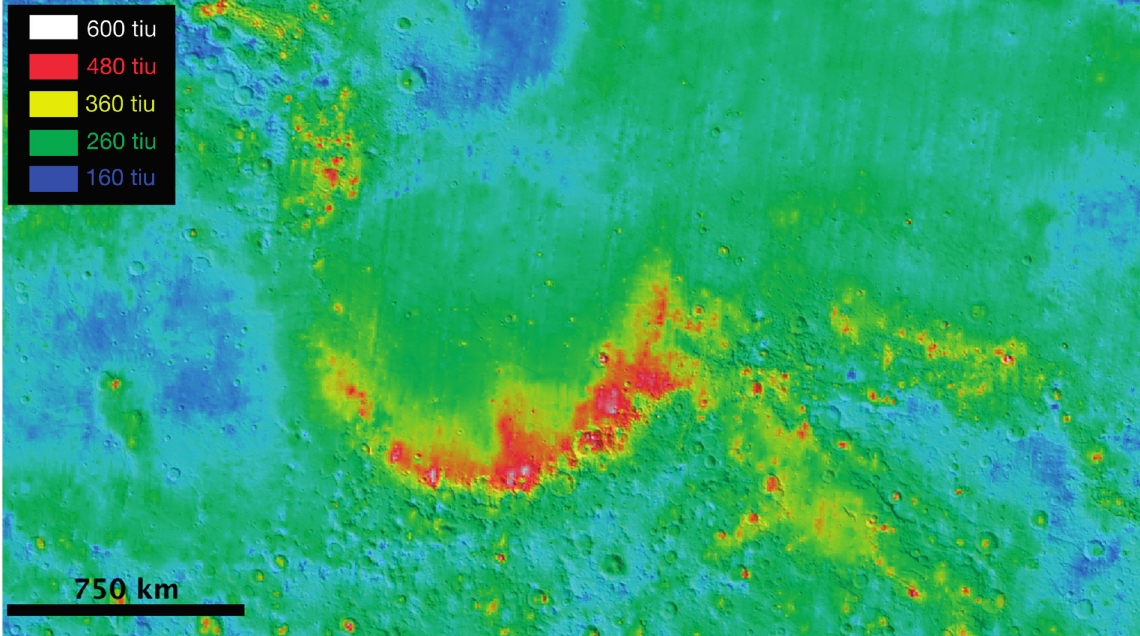
Figure 3. Variation of thermal inertia values adapted from [33]. Thermal inertia units are given as tiu (1 tiu = 1 J m − 2 K − 1 s − 1/2 ) and are only approximately representative of the